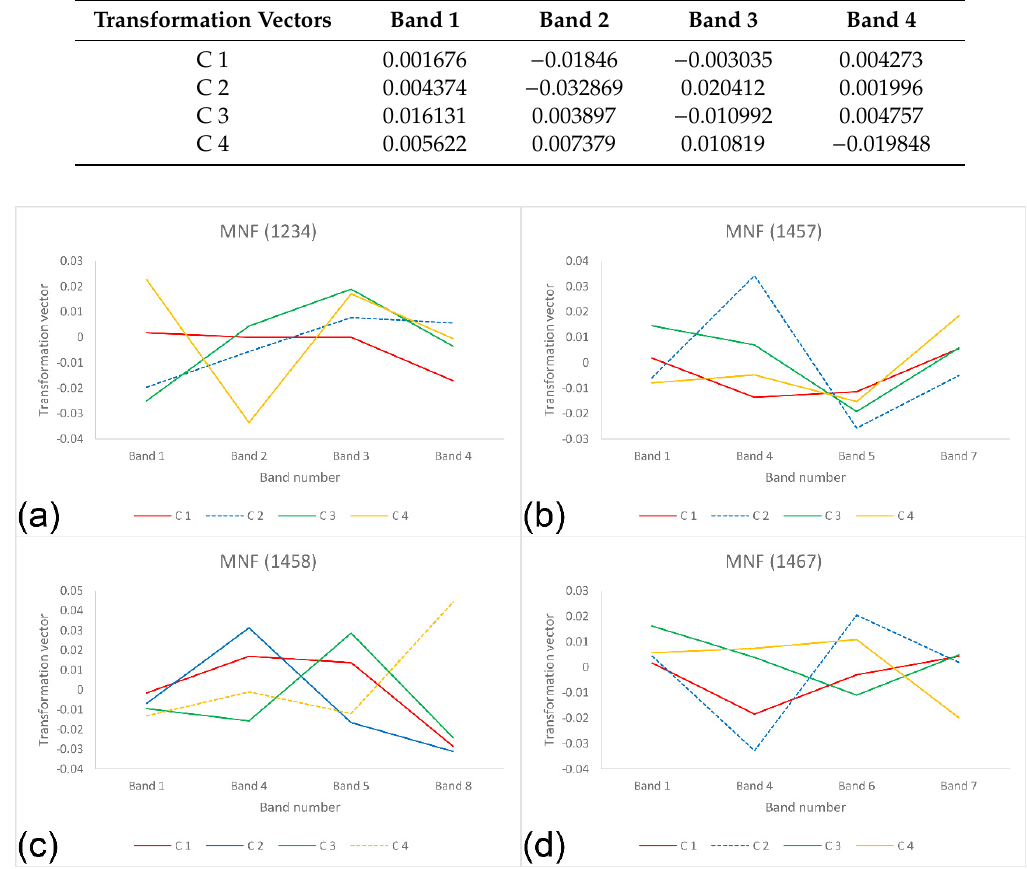
Table 8. Transformation vectors of MNF analysis on a spectral subset of the ASTER data for detecting the phyllic alteration zones in the study area.